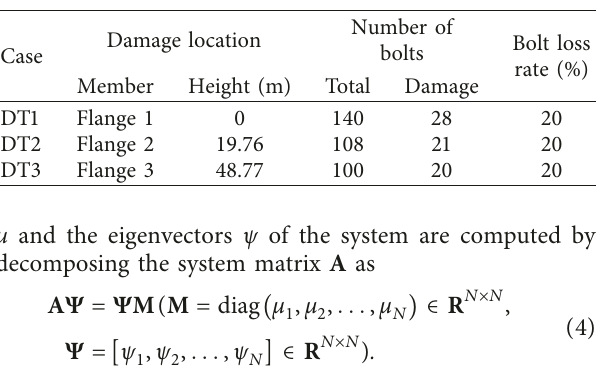
Figure 9: Simulation of damaged bolts in the tower flange. Table 5: Scenarios of bolt damage in the tower